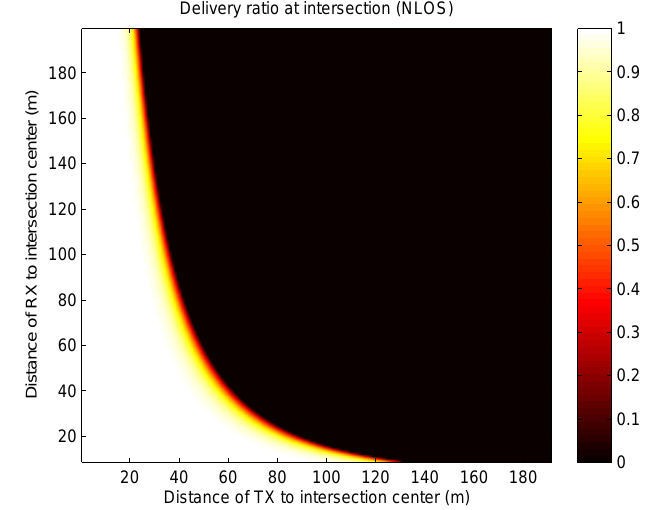
Figure 3. Delivery ratio of safety message at intersection on basis of Equation (8) without road-side unit (RSU)